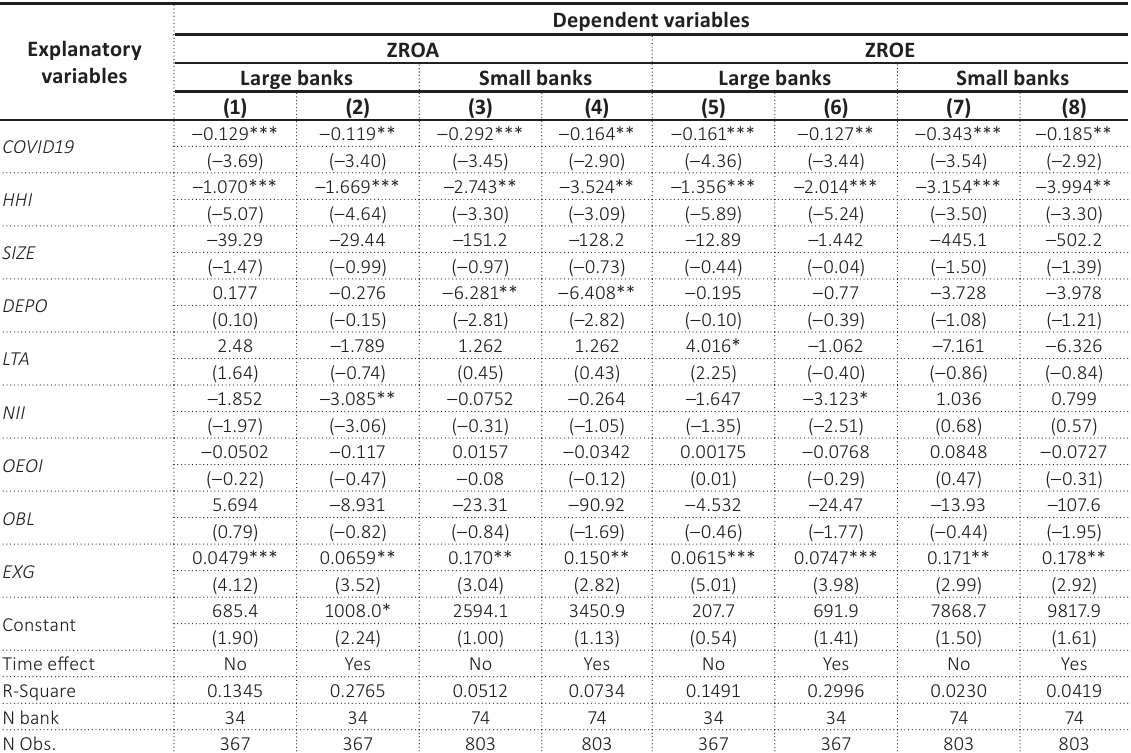
Table 4. COVID-19 and bank stability – large vs small